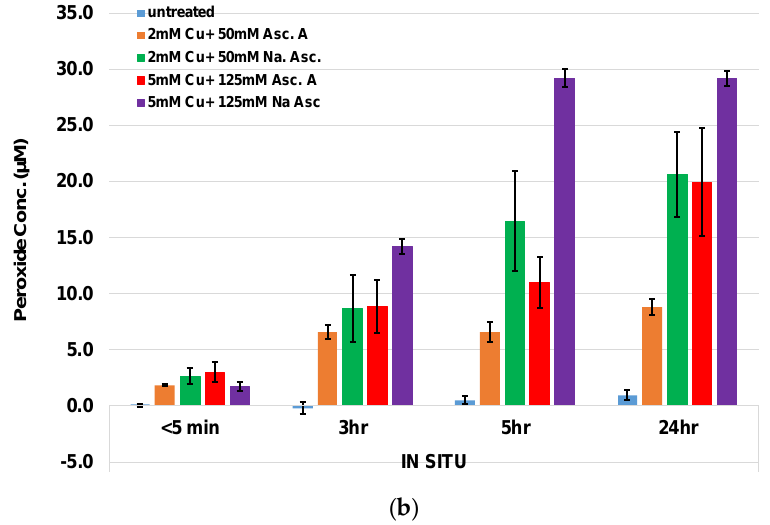
Figure 3. Peroxide generation of hydroentangled nonwoven greige cotton fabric enhanced using different methods, i.e., ( a ) surface adsorption and ( b ) in situ formation of copper particles determined by the Amplex Red assay, with the [AR] and [HRP] final concentration totaling 200 µM and 0.05 U/mL, respectively.